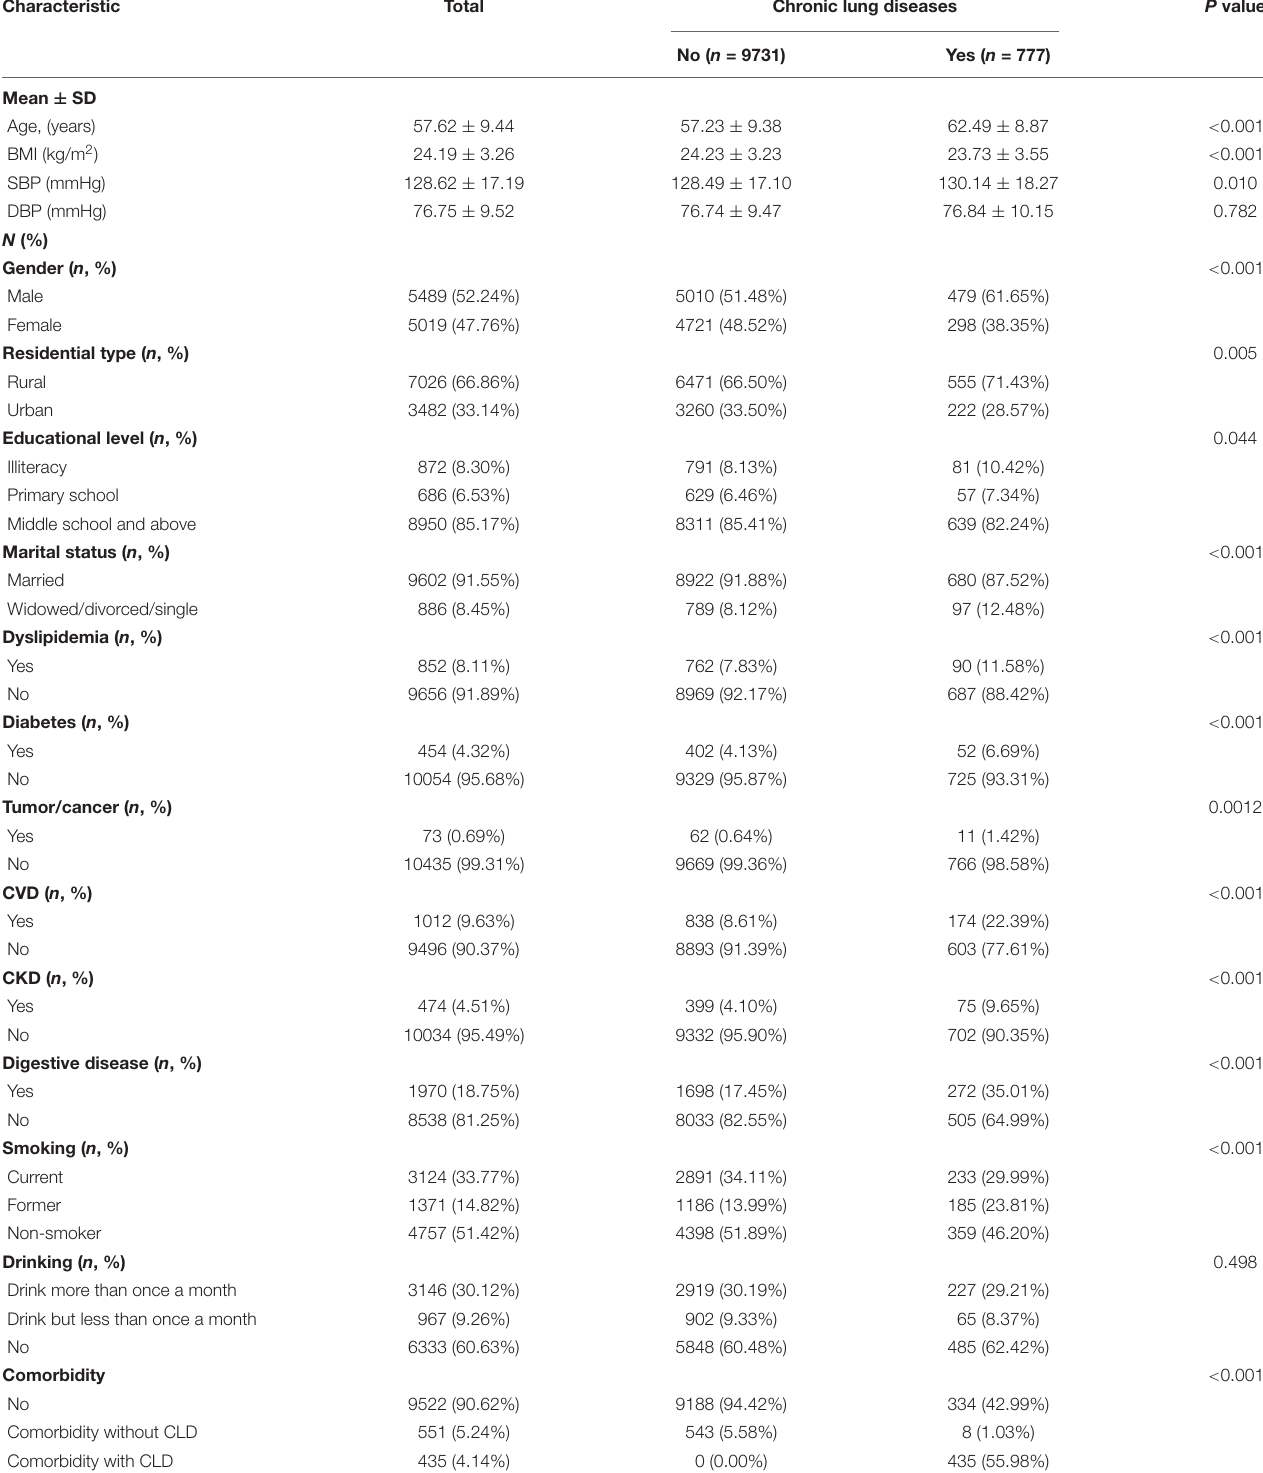
TABLE 1 | Baseline characteristics of participants ( N =